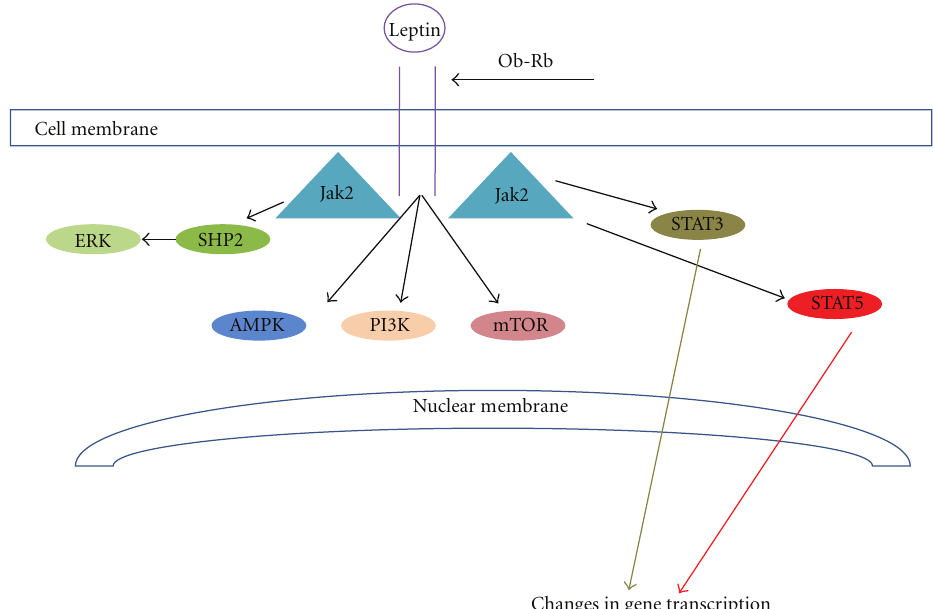
Figure 1: Signalling downstream of leptin binding to the Ob-R receptor. A number of pathways are activated. JAK-2-mediated phosphorylation of Tyr 985 on Ob-Rb activates SHP2 and subsequently ERK. Phosphorylation of Tyr 1077 and to a lesser extent Tyr 1138 activates STAT5, whilst phosphorylation of Tyr 1138 activates STAT3. Activation of STAT transcription factors leads to alterations in gene expression. The biochemical pathways leading to activation of PI3kinase, AMPK, and mTOR when leptin binds Ob-Rb are less well